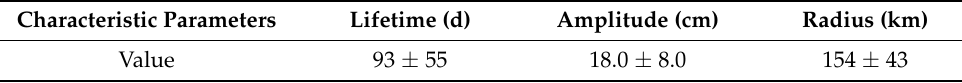
Table 1. Characteristics of the along-the-isobath mesoscale